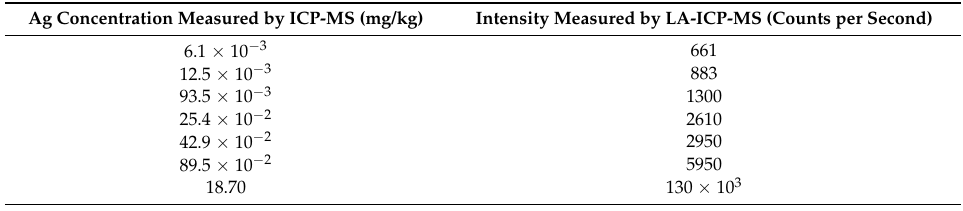
Table 2. Calibration of matrix-matched standards by ICP-MS and LA-ICP-MS. Ag Concentration Measured by ICP-MS